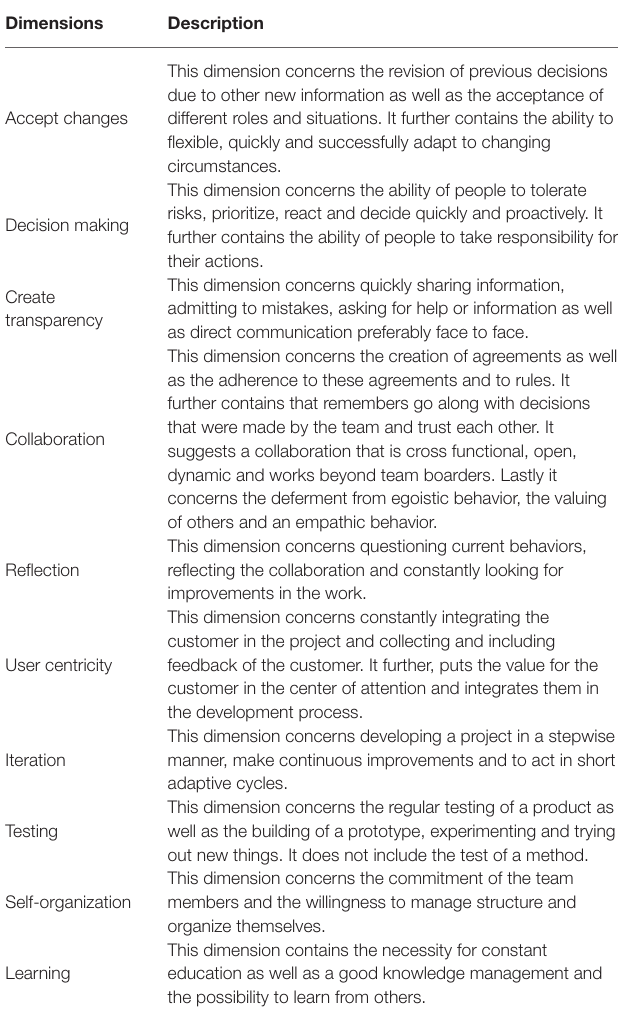
TABLE 1 | The workforce agility model of Petermann and Zacher